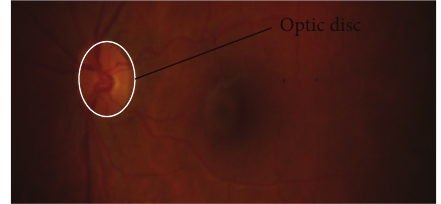
Figure 3: Optic disc in fundus